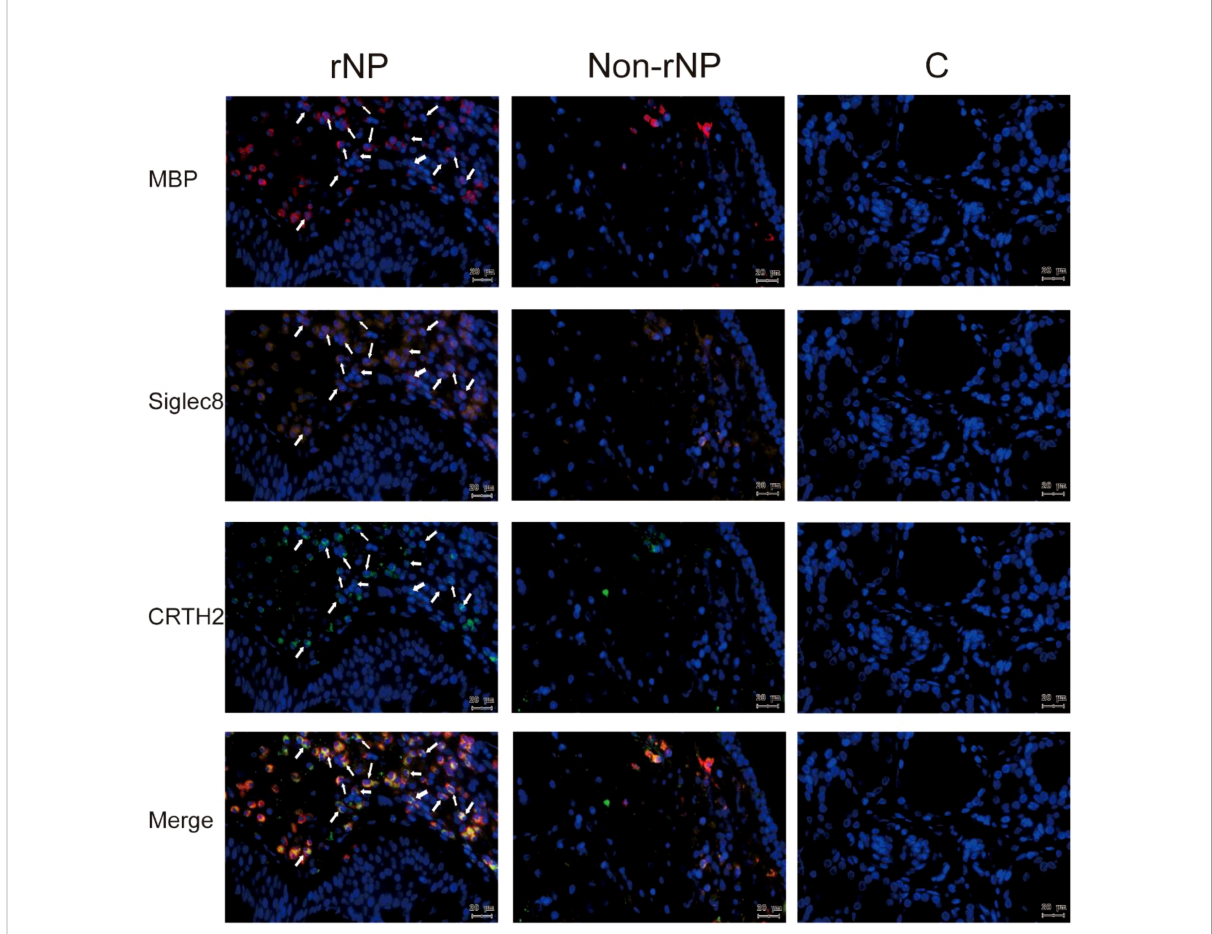
FIGURE 3 Multiplex immuno fl uorescence staining of nasal tissues for MBP (red), Siglec8 (orange), CRTH2 (green), and DAPI (blue) were performed. Representative fl uorescence images of rNP group, Non-rNP group, and control group. White Arrows indicated eosinophils that expressed the corresponding markers. C, control